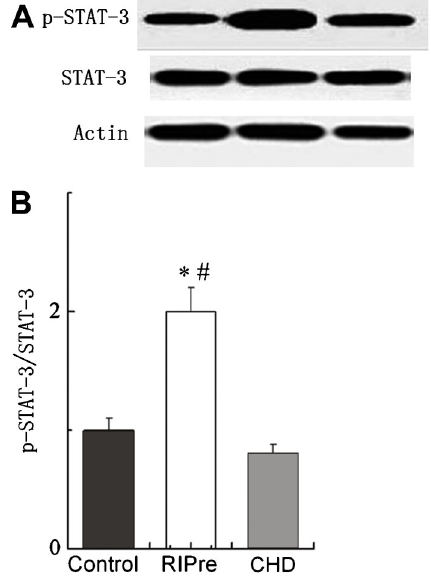
Figure 3. A , Representative Western blot of phosphorylated STAT-3 (p-STAT-3), total STAT-3, and actin in arterial tissue. B , Ratio of p-STAT-3 to STAT-3. Data are reported as means±SE for n=20 in each group. RIPre: remote ischemic preconditioning; CHD: coronary heart disease. *P , 0.05 vs control group; # P , 0.05 vs CHD (Student-Newman-Keuls test). Note that the immunoblots do not exactly reflect the mean values of all samples.